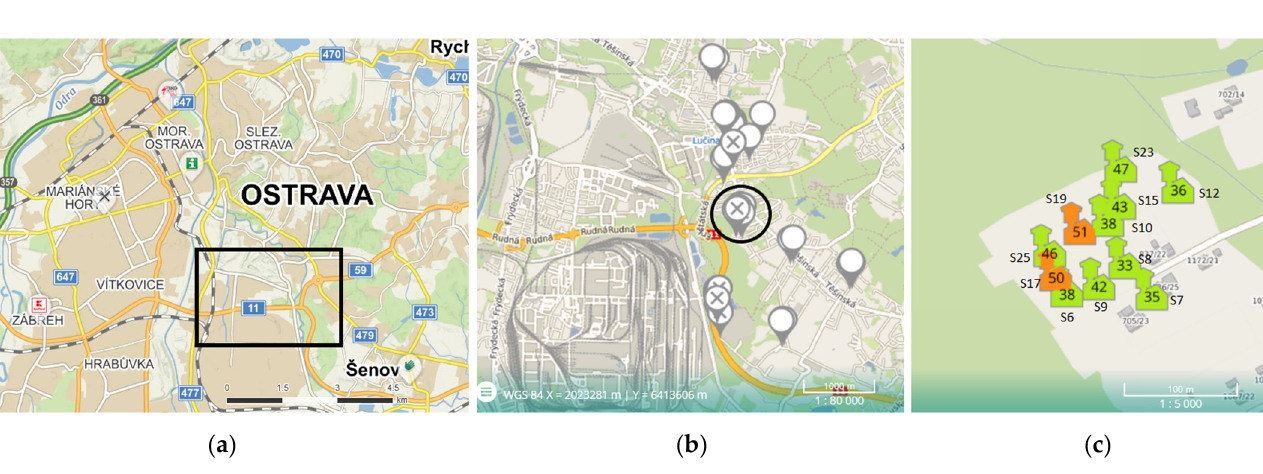
Table 1. Technical specifications of the Alphasense OPC-N3 sensor.